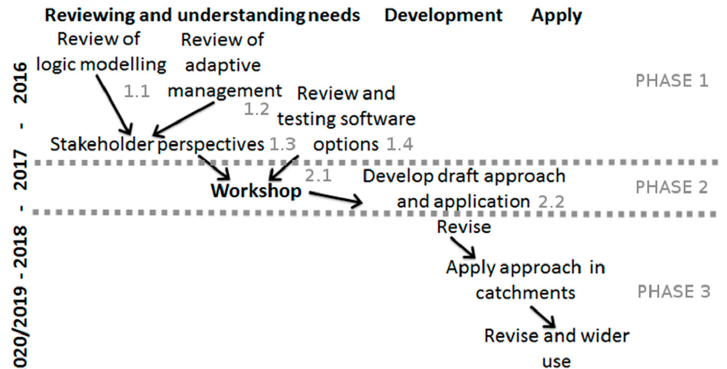
Figure 1. Conceptual process design for stakeholder-driven development of an outcomes-based Environmental Decision Support System (EDSS).